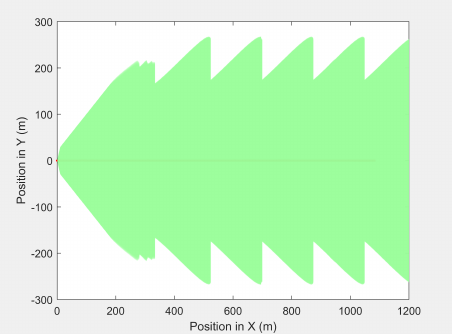
Figure 8. The UAV’s camera look-ahead coverage footprint along the MGV’s path.